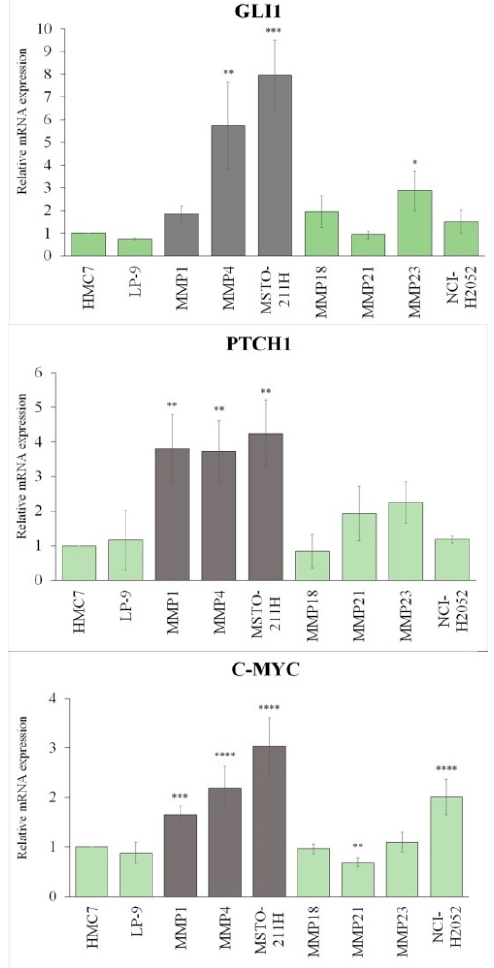
Figure 3. qRT-PCR analysis of GLI1 , PTCH1 and c-MYC. The expression of Hh-related genes is upregulated in MPM cells loosing PC (gray bars), compared to normal mesothelial cells HMC7. (* p < 0.05, ** p < 0.01, *** p < 0.001, **** p < 0.0001).